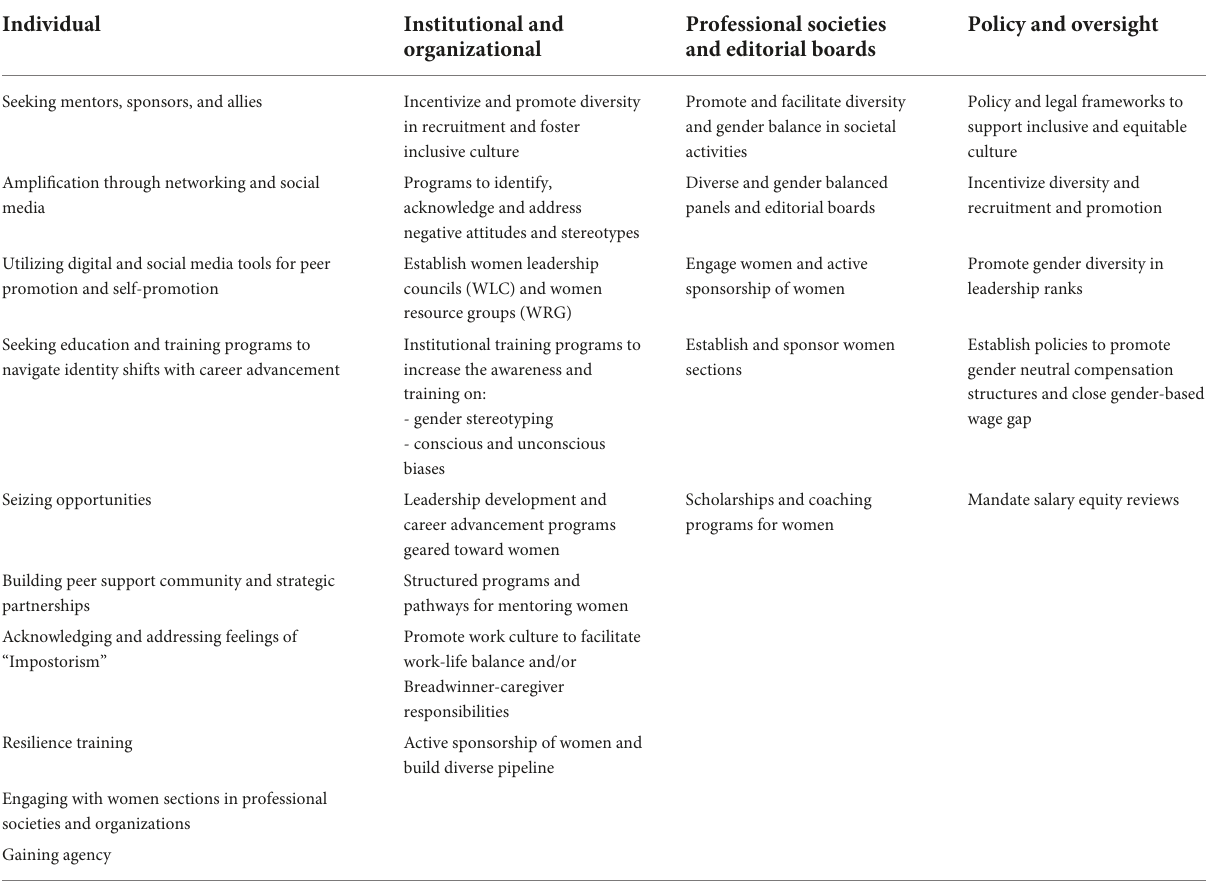
TABLE 3 Strategies to improve representation and professional advancement.